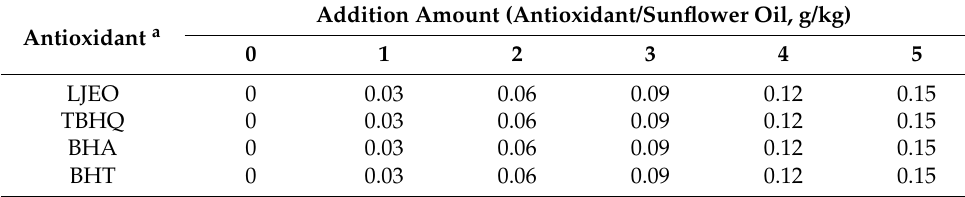
Table 1. The amounts of the antioxidants added to sunflower oil samples. Addition Amount (Antioxidant/Sunflower Oil, g/kg) Antioxidant a 0 1 2 3 4 5 LJEO 0 0.03 0.06 0.09 0.12 0.15 TBHQ 0 0.03 0.06 BHA 0 0.03 BHT